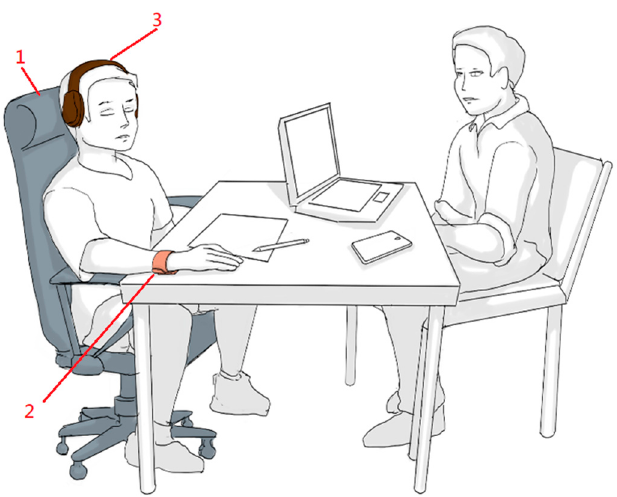
Figure 3. Sketch of the experimental set-up: The subject ( left ) is sitting on the Haptic Chair (1) and has their non-dominant hand placed on the Embr wave bracelet (2) affixed to the table. The conductor ( right ) controls the haptic feedback via the computer and thermal feedback using the Embr wave smartphone app. During each trial, white noise is played to the subject using the headphones (3). At the end of each trial, the subject documents his or her response in the form